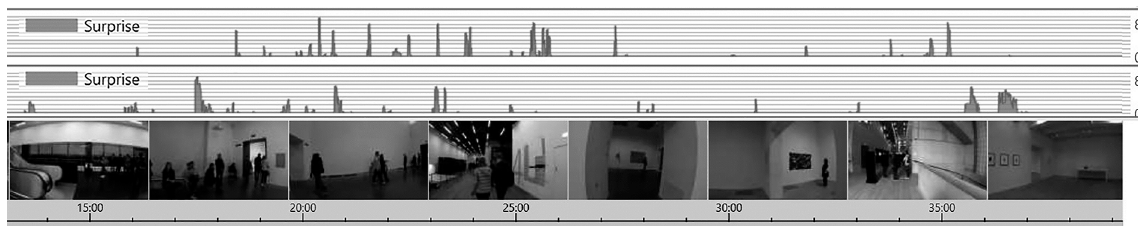
Figure 1. Sample output of different emotions. The highlighted reaction reflects the expression seen in the image.